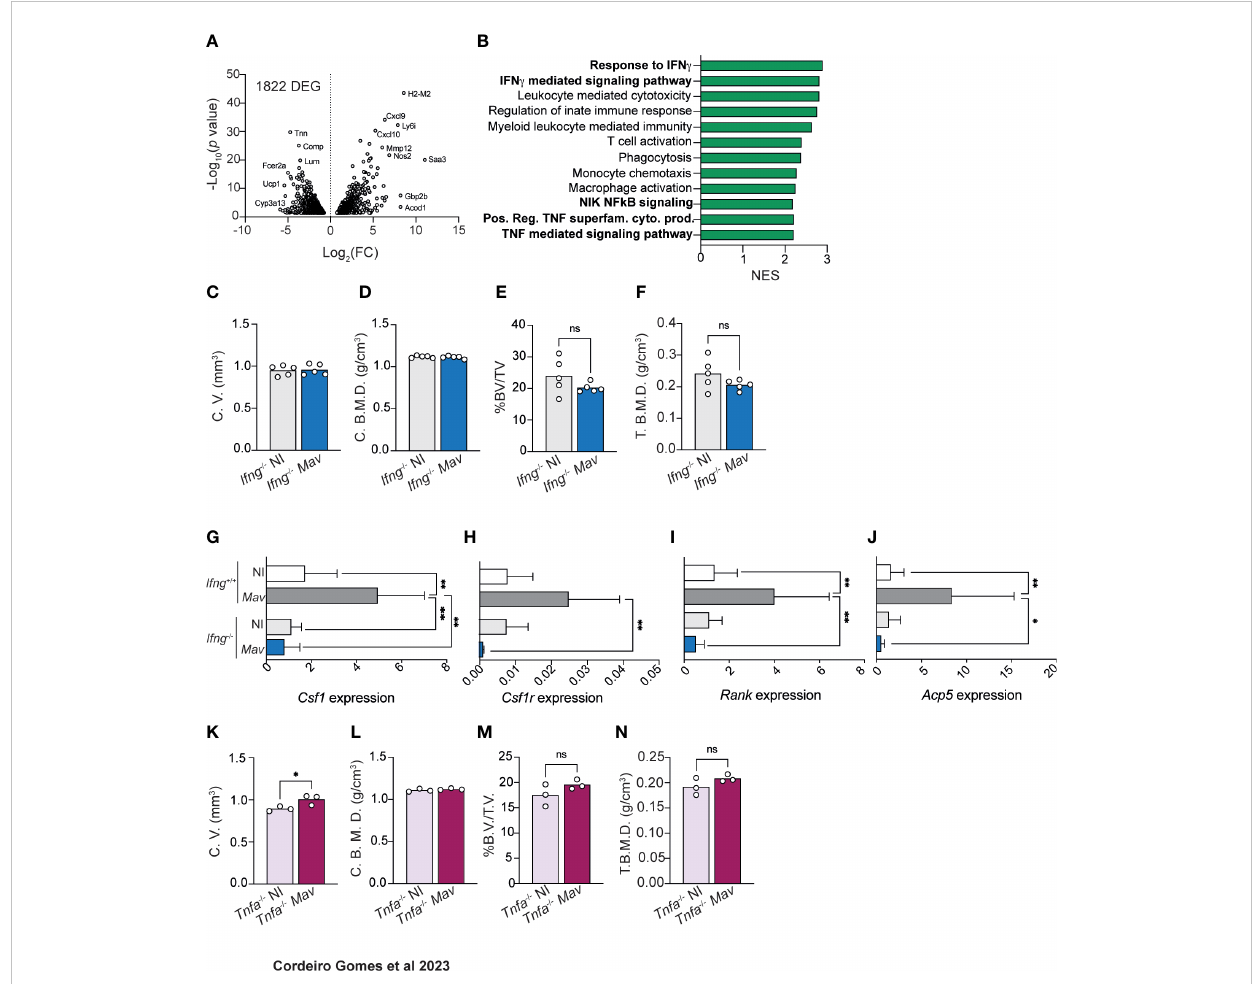
FIGURE 2 Bone mass reduction during chronic M. avium infection is dependent on IFN g and TNF a production. (A) Volcano plot of the differentially (and statistically signi fi cant) expressed genes in the bone of M. avium -infected mice compared to non-infected littermate control mice. (B) Differentially upregulated pathways (from the GO Biological Process dataset) in the bone of infected mice compared with non-infected controls. (C, D) Measurement of the cortical volumes (C. V., C), and cortical bone mineral density (C. B. M. D., D) in M. avium -infected ( Mav bars) compared to non-infected mice (NI bars). (E, F) Measurement of the ratio of bone volume to tissue volume (%BV/TV, E), and trabecular mineral bone density (T. B. M. D., F). N=5 mice per experimental group; data representative of two independent experiments. Bars indicate average; circles depict each individual mouse analyzed. n.s., p>0.0,5 by Mann-Whitney test. (G – J) Expression of Csf1 (G) , Csf1r (H) , Rank (I) , Acp5 (J) , in the bones of infected ( Mav bars) and non-infected (NI bars) Ifng -/- and Ifng +/+ mice. Bars represent the average ± standard deviation of the experimental group. *, p<0.05, ** p<0.01 by two-way ANOVA. (K, L) Measurement of the cortical volumes (C. V., K), and cortical bone mineral density (C. B. M. D., L). (M, N) Measurement of the ratio of bone volume to tissue volume (%BV/TV, M), and trabecular mineral bone density (T. B. M. D., N). N=3 mice per experimental group; data representative of two independent experiments. Bars indicate average; circles depict each individual mouse analyzed. n.s., p >0.05 by Mann-Whitney